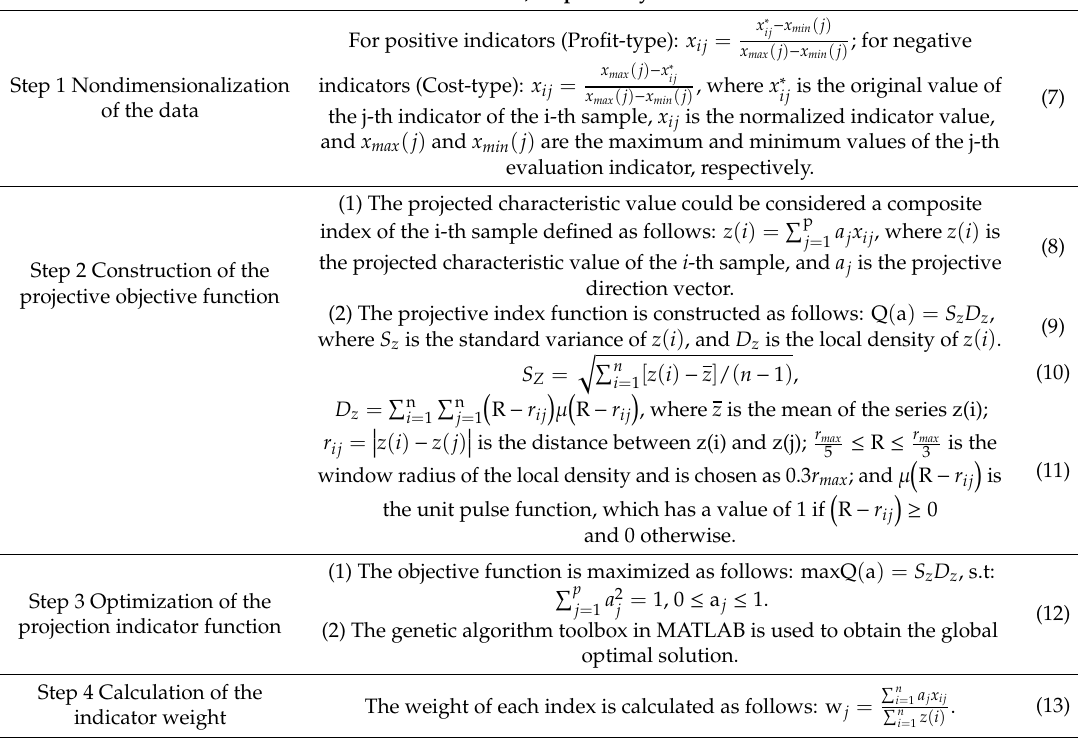
Table 3. Steps of the weight determination process by projection pursuit clustering (PPC). | i = 1 , 2 ,. . . , n , j = 1 , 2 ,. . . , p }, where n and p are the numbers of samples and The sample set of indicators is set as { x * ij indicators,